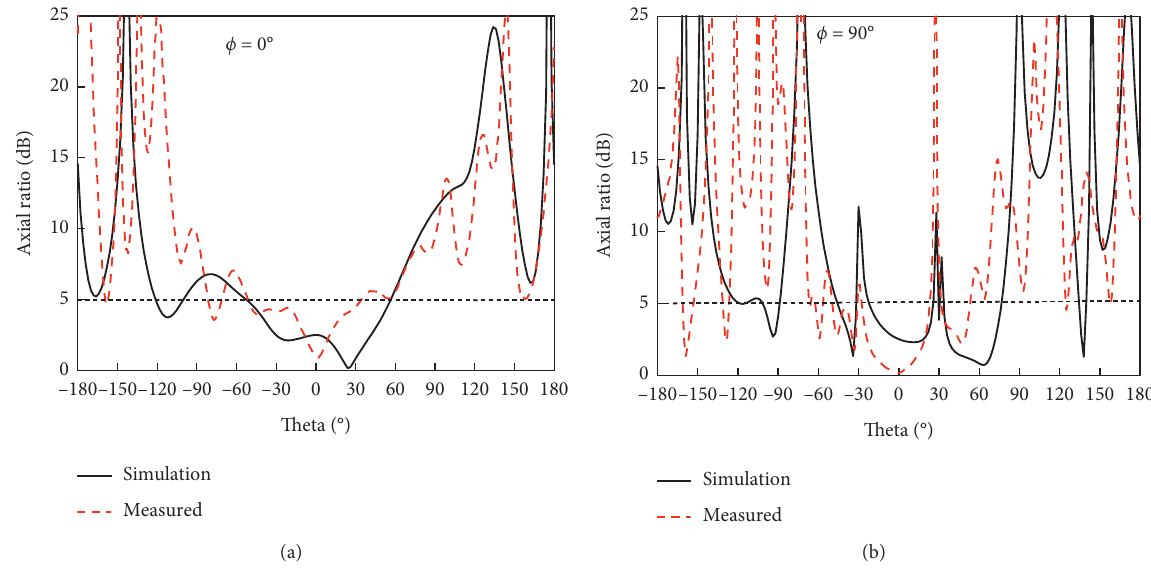
Figure 14: Measured and simulated axial ratio of proposed antenna array at 2.6GHz: (a) xoz -plane; (b) yoz -plane. Table 2: Comparison between proposed and other reported PRA.